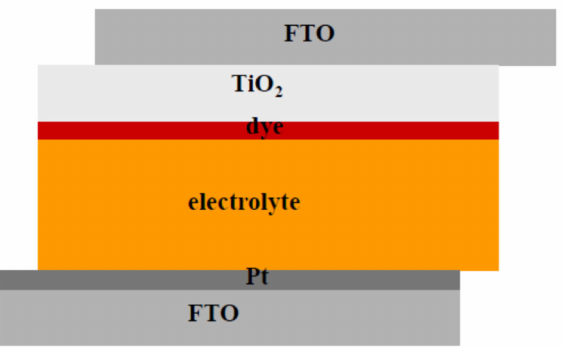
Figure 1. DSSC structure: FTO/TiO 2 /Dye/Electrolyte/Pt/FTO (FTO: fluorine-doped tin oxide on